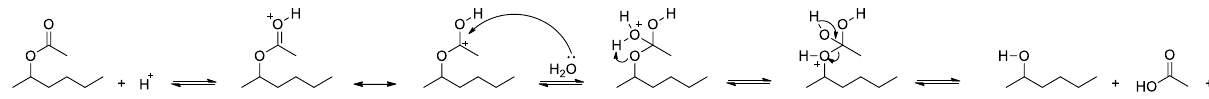
Figure 3. Non-irradiated and γ-irradiated 2,6-di-tert-butyl-p-cresol in polymer matrix simulating (left to right: 0, 25, 50, 100, and 250 kGy)